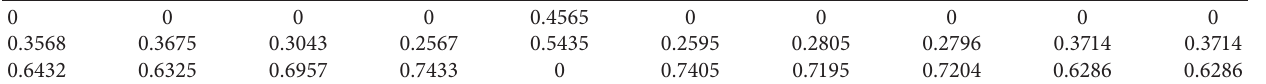
Table 1: The membership results of the SNCM algorithm on the Wine data set.